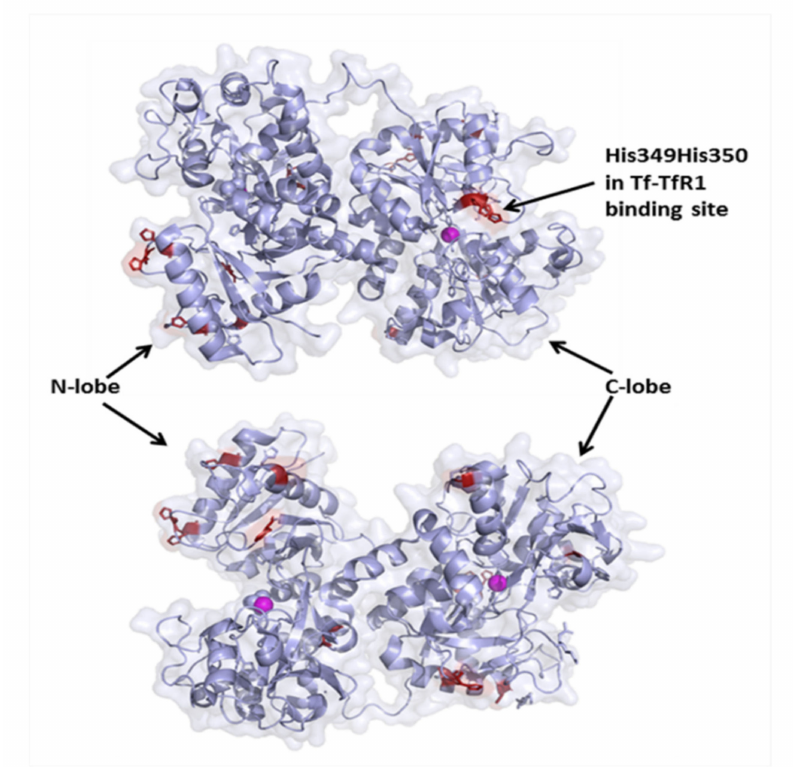
Figure 3. Two views (front and back) of the crystal structure of holoTf (PDB entry 3QYT, processed with PyMOL software) [65]. Pink spheres are the Fe(III) ions, and His residues that lie close to the protein surface and are likely to be available for Ru(III) binding [26,67] are shown in red. The marked His residues (349 and 350) occur at the C-lobe binding site to TfR1